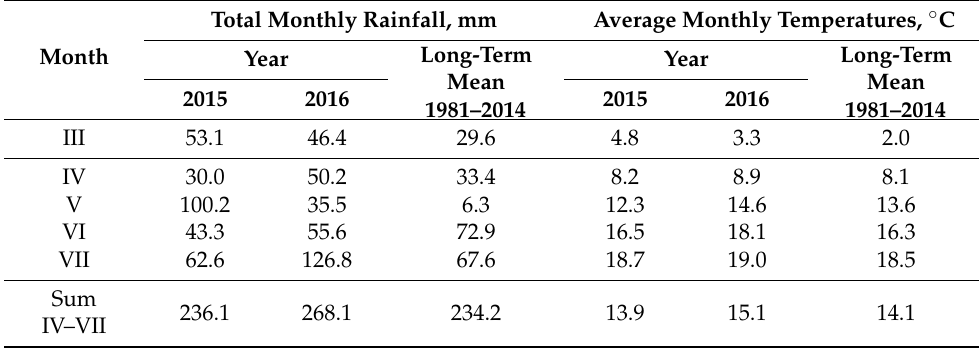
Table 2. Rainfall and air temperatures in 2015–2016, (Institute of Meteorology and Water Management, National Research Institute in